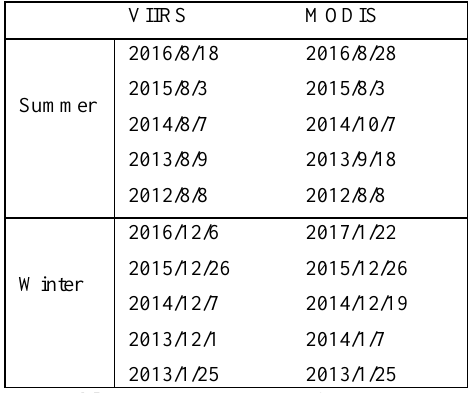
Table.1 selection schedule of study data